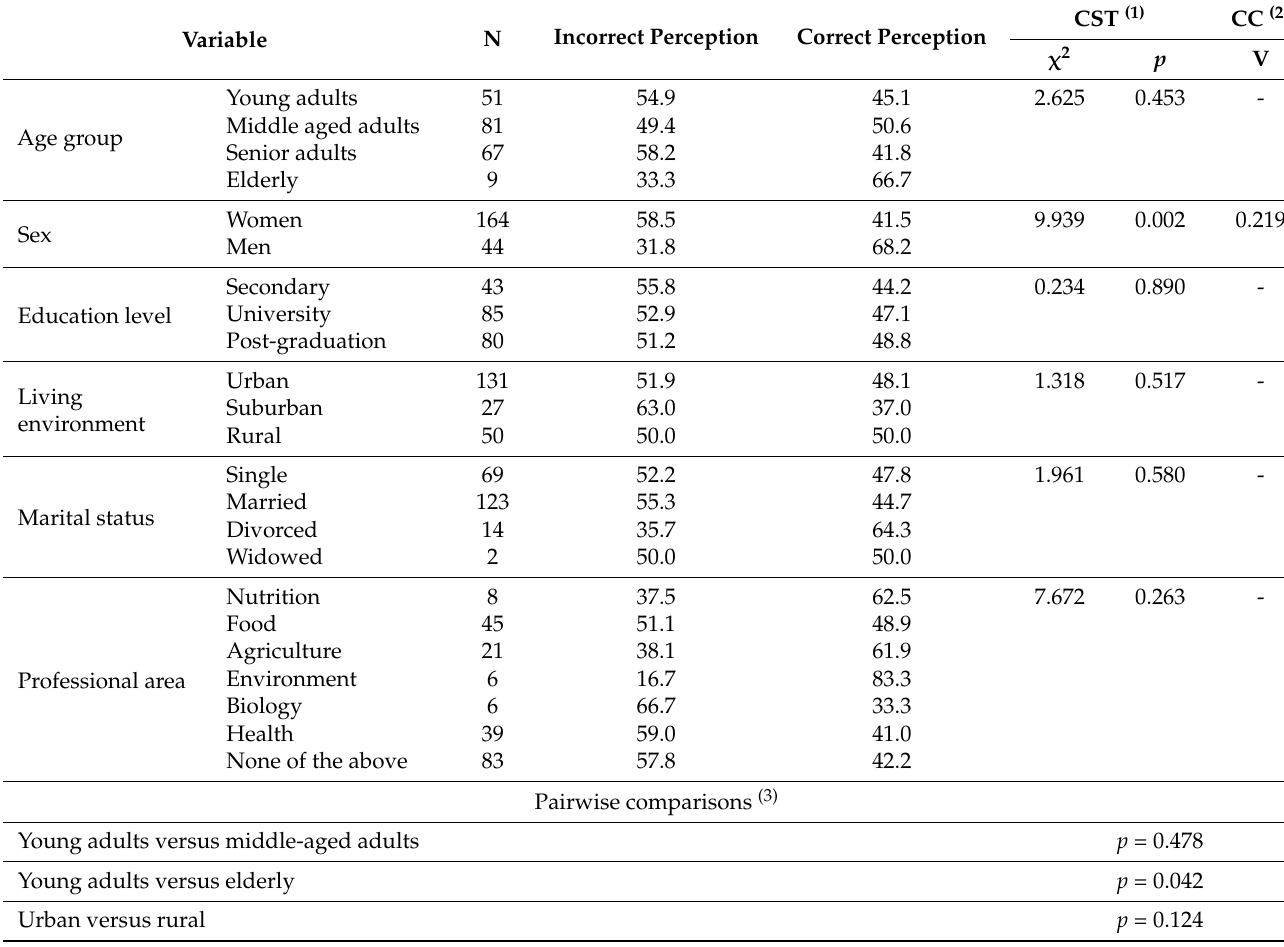
Table 4. Associations between the perceptions about EI and derived products and the sociodemographic variables studied.